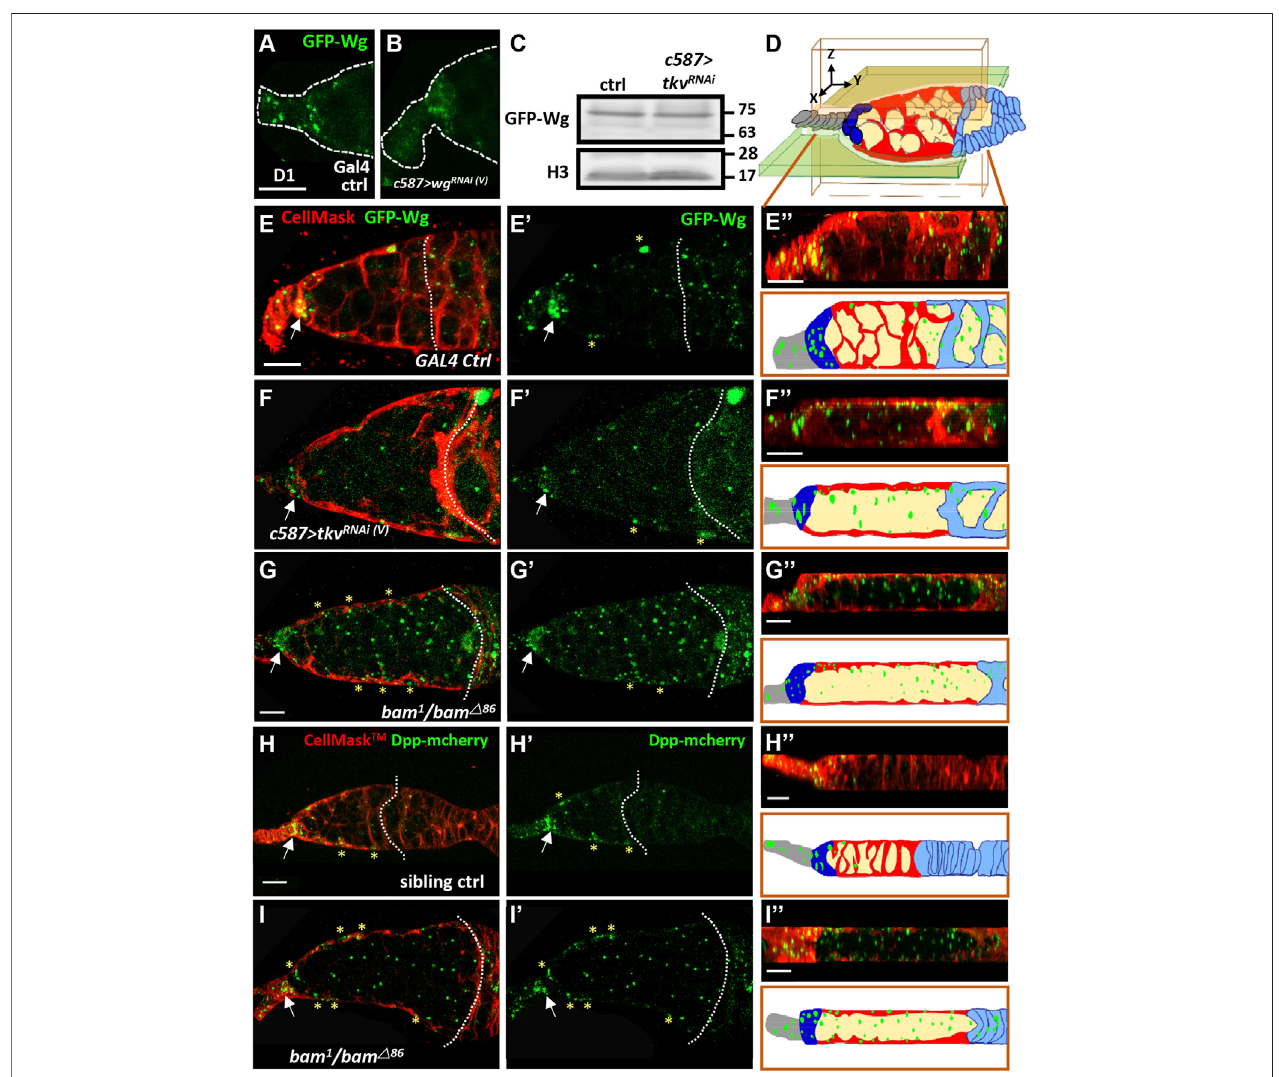
FIGURE6| Cellular protrusions ofescortcellsserve asa physical permeability barriertopreventWg and Dpp distributionin thegermline. (A and B) Live images of anterior part of 1-day (D)-old GAL4 control (ctrl) (A) and c587 > wg RNAi germaria (B) bearing GFP-wg (green). Dashed lines show the edge of the germarium. (C) Representative immunoblot shows that Wg-GFP expression (anti-GFP antibody) is similar in 1-day (D) -old control (ctrl) and c587 > tkv RNAi (V) ovaries. Histone (H3) was used as a loading control. Molecular weight markers are indicated to the right of the blots. (D) Schematic of a germarium with a three-axis (X, Y, and Z) coordinate system.The directionsofeach axisareshown.TheY-axis isde fi ned asanteriortoposterior. An XYsection isshown asthelightgreenshaded area, andan XZsectionis shown asa lightpink shaded area. Terminal fi lament cells, gray; capcells, dark green; escortcells, red; germ cell, lightyellow; follicle cells, light blue. (E – I) Live images of 1-day-oldGAL4control (E) , c587 > tkv RNAi(v) (F) ,and bam 1 /bam △ 86 mutant (GandI) ,siblingcontrolgermaria (H) ,bearing GFP-wg (greeninE-G),Dpp-mcherry(greenin H and I) and labelled with CellMask (red, cell membrane). (E ”– I ” ) are optical sections in the XZ plane; the corresponding schematic with the cell types is shown in D and corresponds to (E ’– I ’ ) ; green color shows the distribution of Wg (E ”– G ” ) or Dpp (H ”– I ” ) . Scale bar, 10 μ m; A and B, E and F, and H and I share the same scale bar. Germaria were examined for wg-GFP distribution in control (n = 12), c587 > tkv RNAi(v) (n = 25), and bam 1 /bam △ 86 mutant (n = 15). Germaria were examined for Dpp- mechrry distribution in the control (n = 8), and bam 1 /bam △ 86 mutant (n = 12). Control genotypes in A, C and E are c587 > gfp RNAi(III) , GFP-wg/+ ; in H is ( +/Dpp-mcherry; bam 1 or bam △ 86 /+ ).Arrows pointtothecapcellregion.Dashed lines inEand Hmark the2A/2Bboundary, andF, Gand Hmark inthejunctionbetweenescort cellsand follicle cells (the 2A/2B boundary is lost). Asterisks mark GFP signals present in ECs.